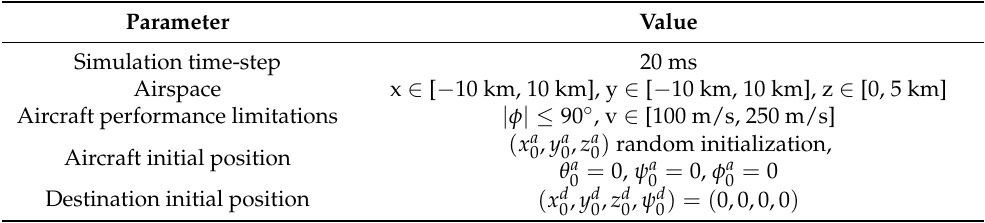
Table 1. Aircraft guidance simulation parameters.